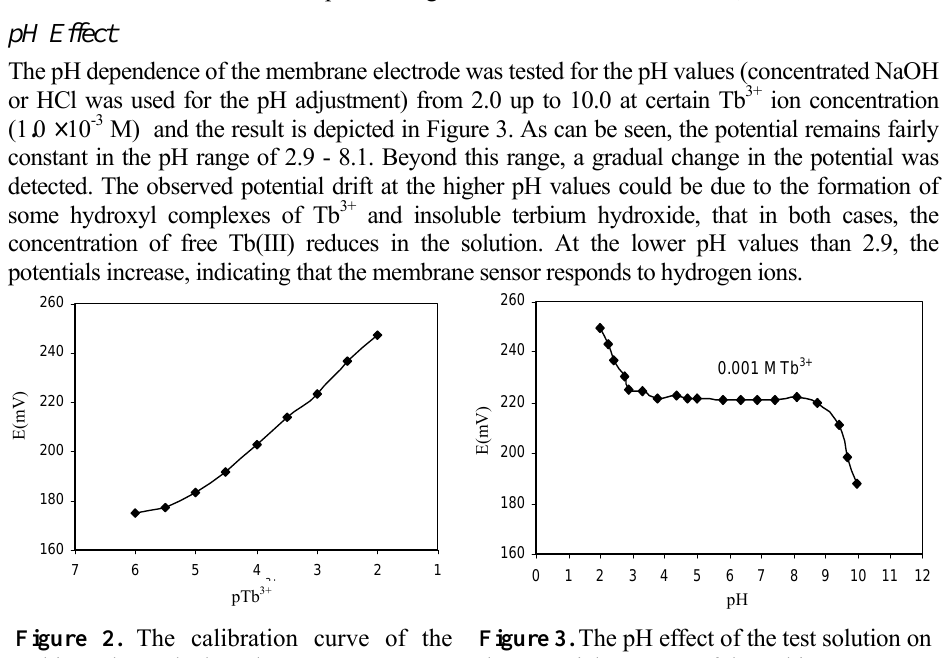
Figure 2. The calibration curve of the terbium electrode, based on PMA